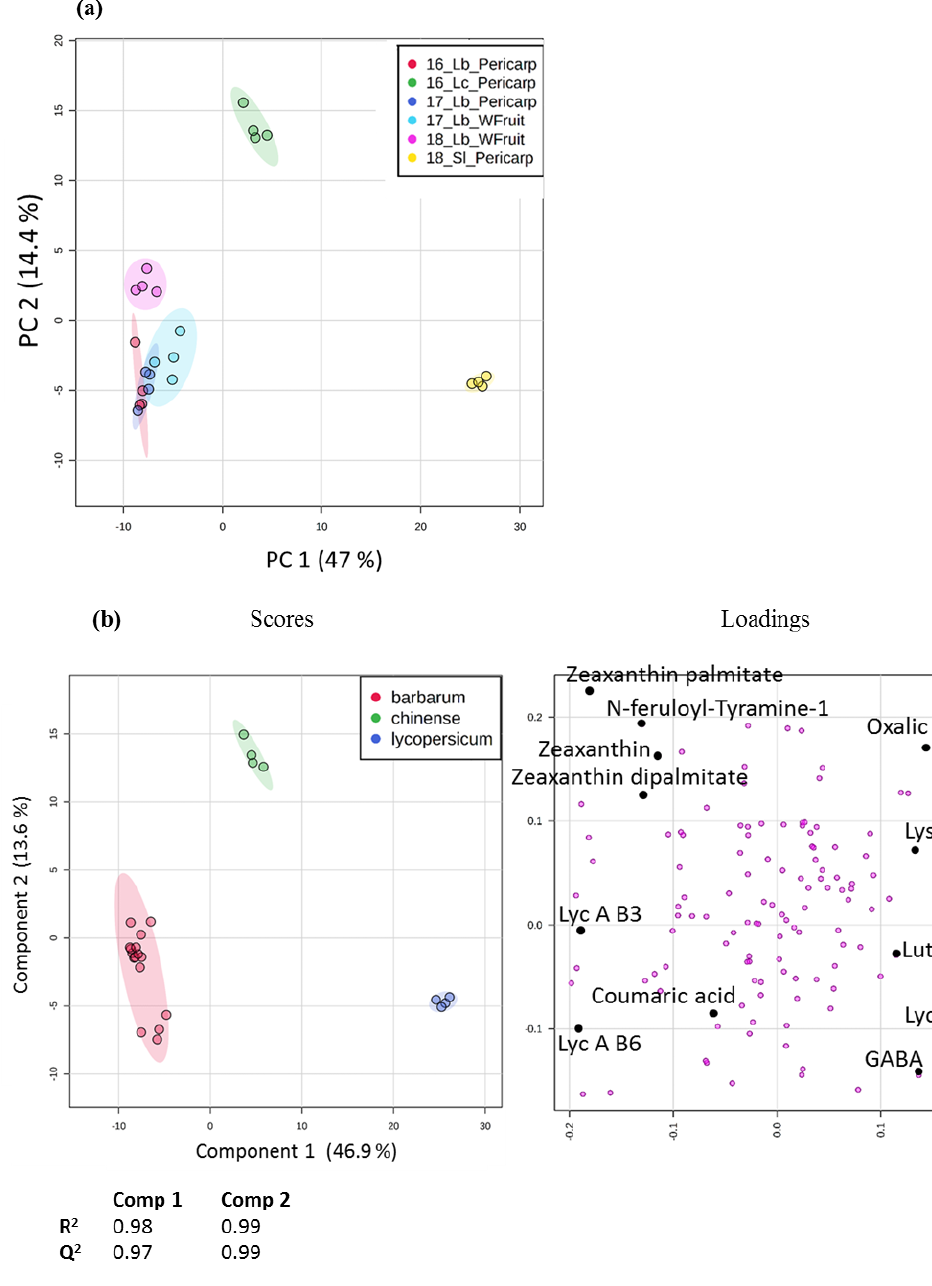
Figure 3. Multivariate analysis of the whole dataset, including 126 metabolites (peak intensities normalized by sample dry weight, log transformed and Pareto scaled) analyzed in 24 samples. ( a ) Score plot of principal component analysis (PCA) on 3 accessions: Lycium barbarum (Lb, in blue, pale blue, pink or dark blue on the score plot); Lycium chinense (Lc, in green); and Solanum lycopersicum (Sl, in yellow). The percentage of variance captured is indicated on each axis. Samples are labeled as follows: Year_Accession_Tissue (Wfruit = whole fruits). ( b ) Partial least-squares discriminant analysis (PLS-DA), R2 and Q2 are detailed below, and some of the most discriminant metabolites are labelled on the loadings